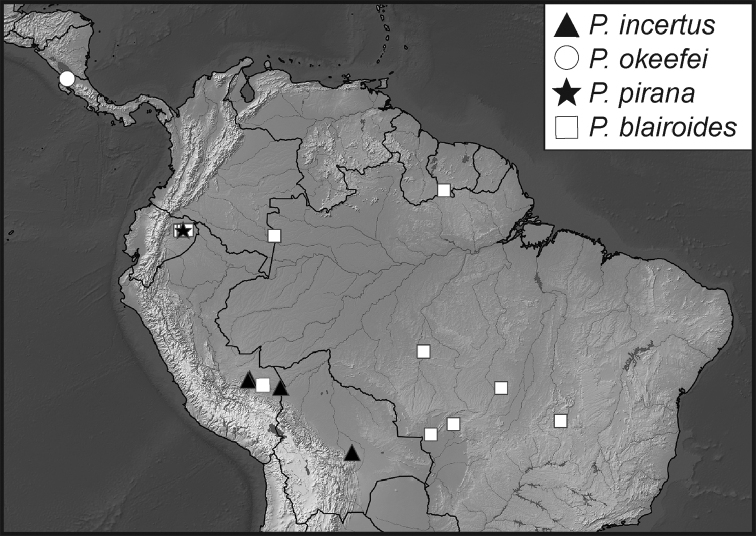
Collecting records for Phelister
incertus (black triangles), P.
okeefei (white circle), P.
blairoides (white squares), and P.
pirana (star).